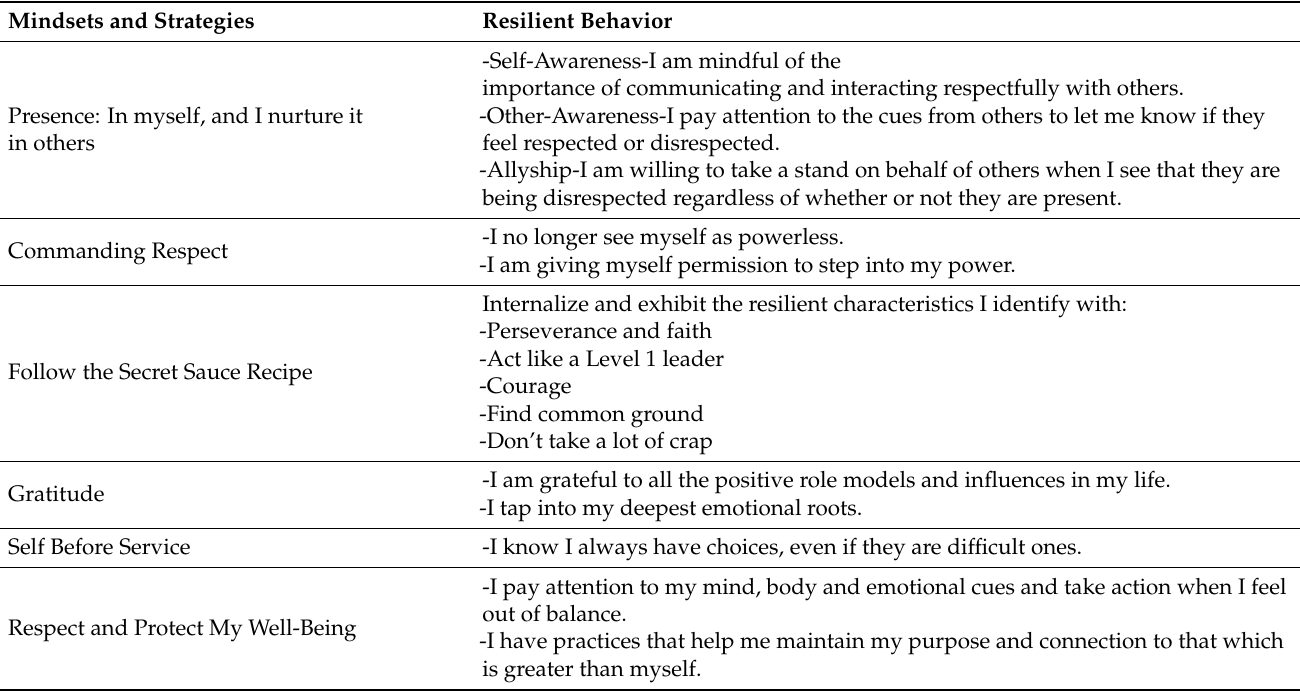
Table 4. Resilience Skills: Mindsets and